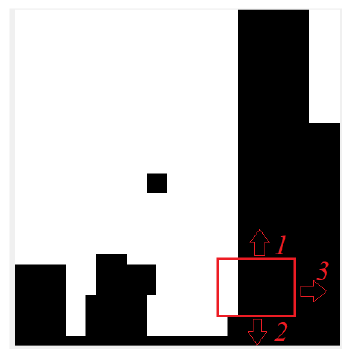
Figure 7 . Extent of pattern. Figure 7. Extent of pattern.